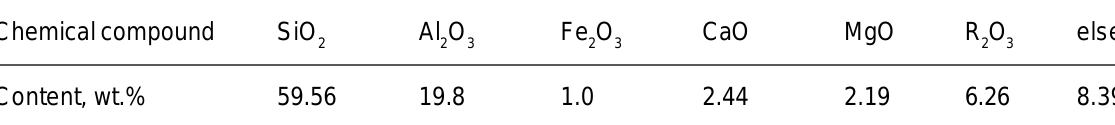
Table 5. The chemical composition of powder obtained by spray drying of ceramic slurry. Chemical compound SiO 2 Content, wt.%